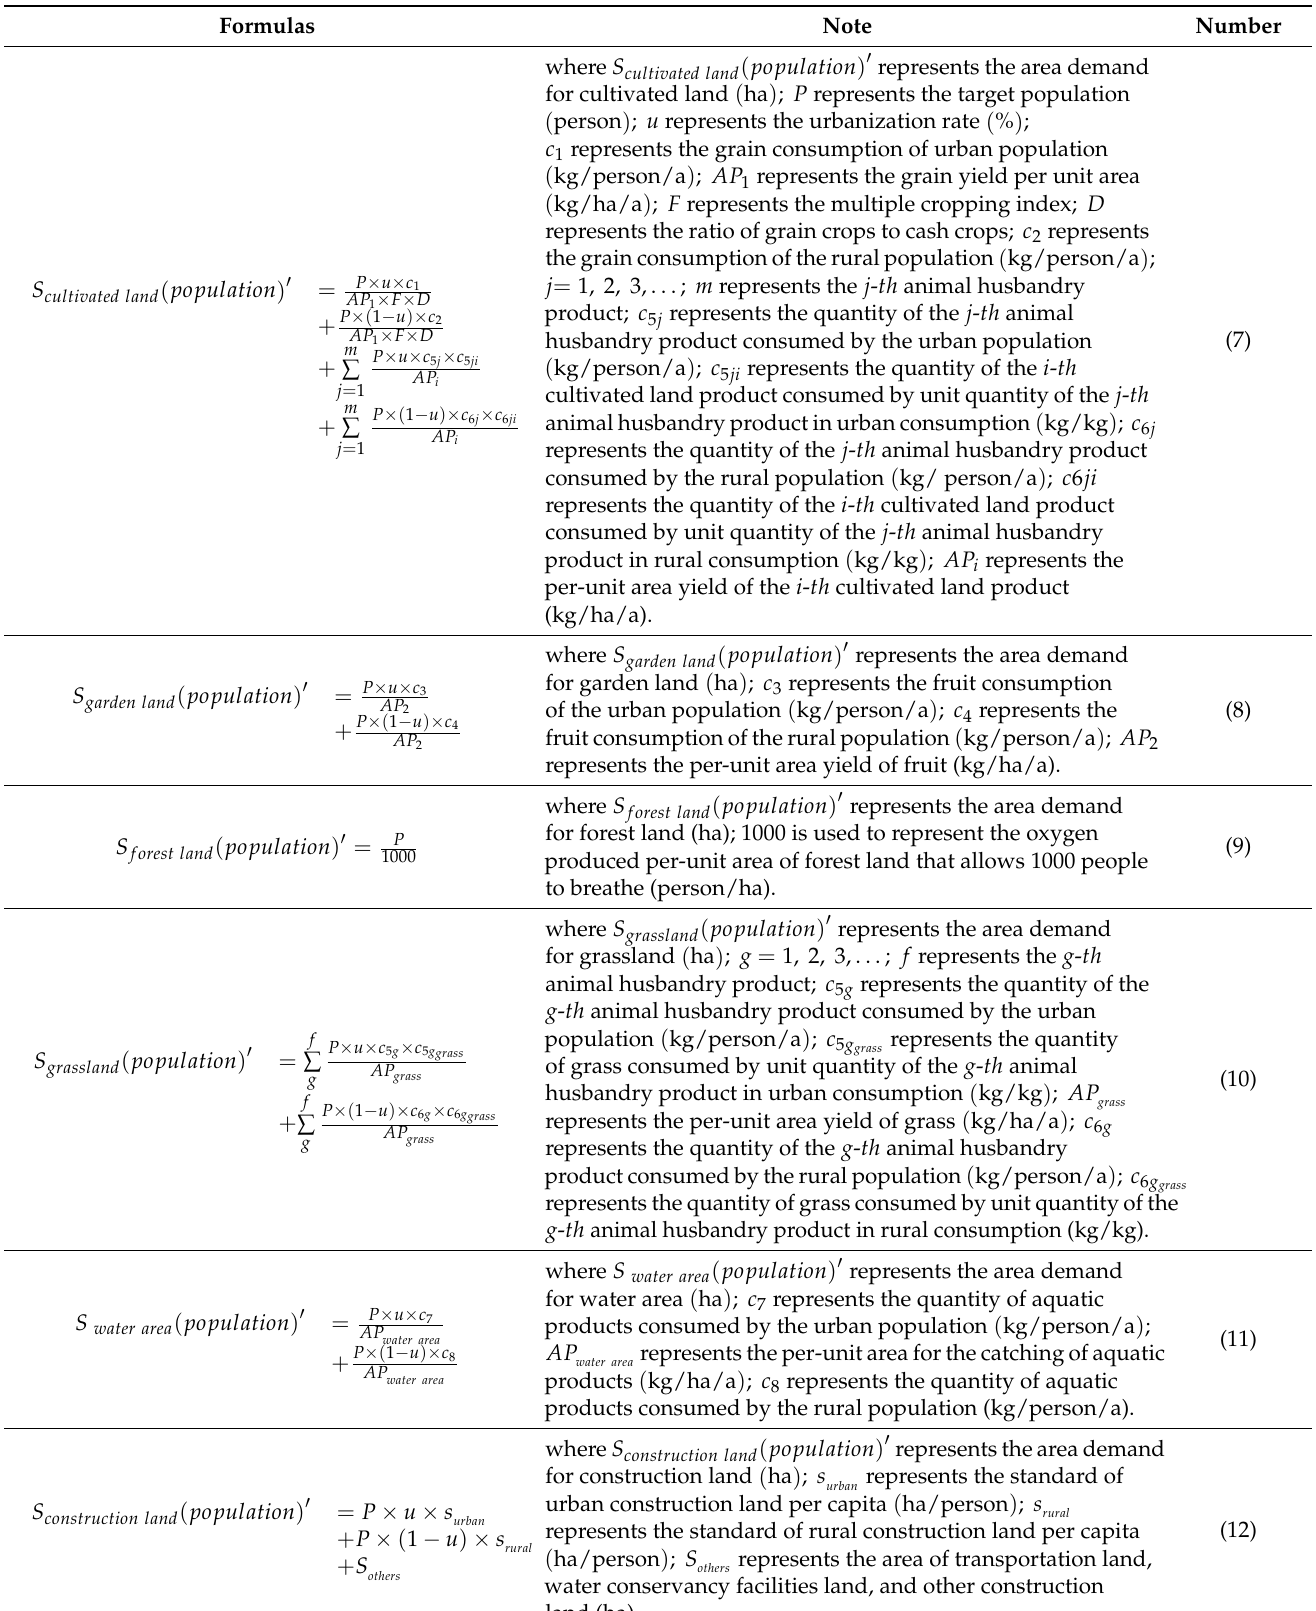
Table 4. Formulas for calculating the demand for land to realize population development.